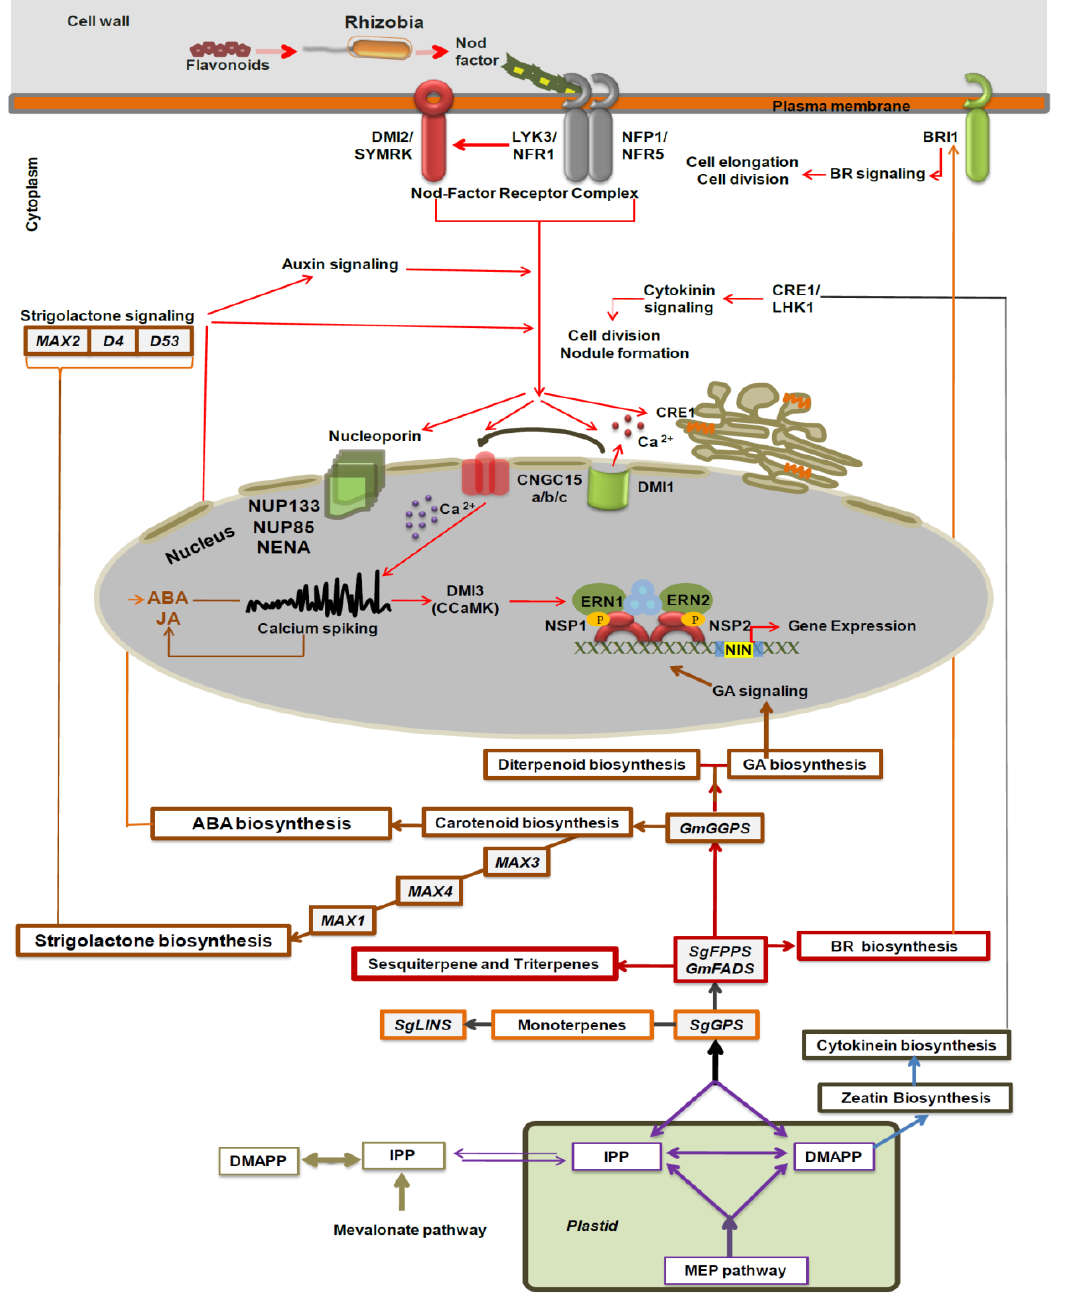
Figure 9. Proposed schematic interactions between terpenoid biosynthesis, terpenoid hormone